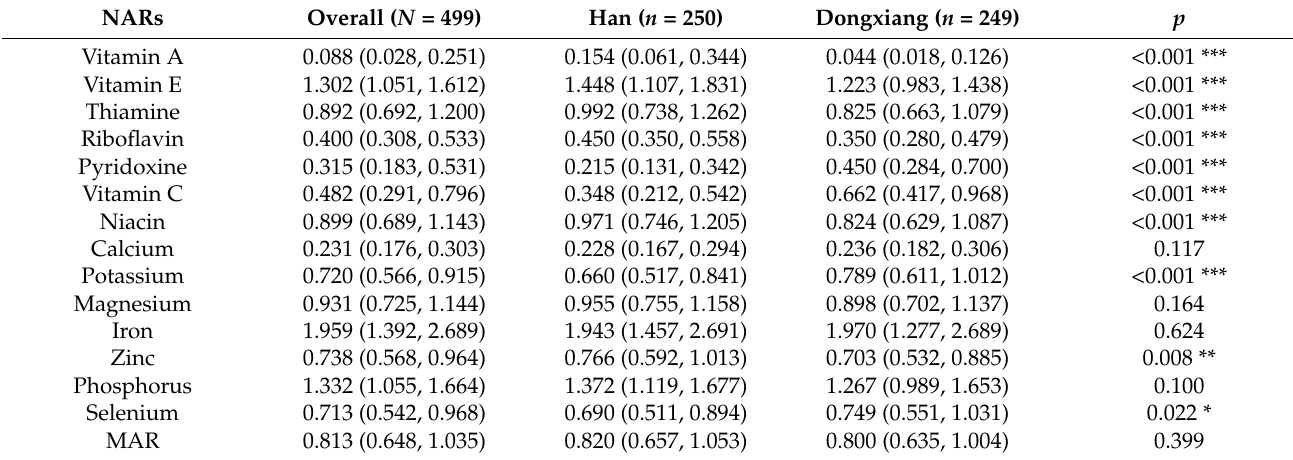
Table 4. Nutrient adequacy ratio of specific nutrients in two ethnicity groups ( N =